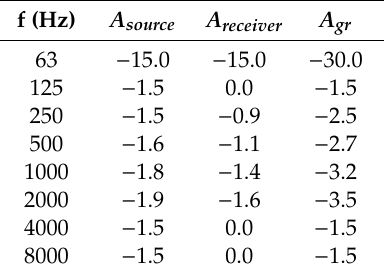
Table 7. Ground attenuation